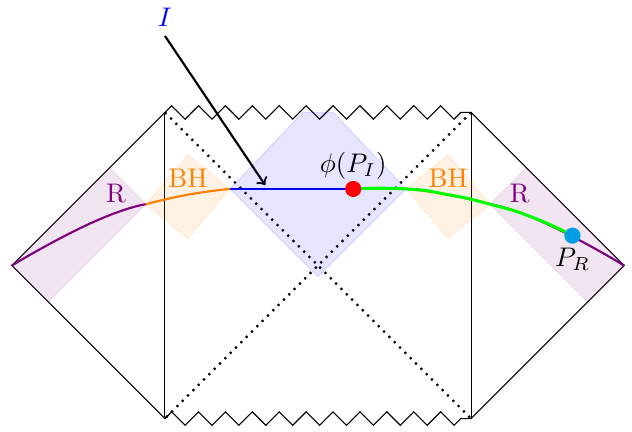
Figure 2 . The Penrose diagram of the AdS black hole attached to the non-gravitating heat bath with a small local operation φ ( P I ) ( P I ∈ I , red dot) in the island region I . The entanglement wedge of the black hole BH (orange shaded region) includes the asymptotic AdS boundary. The gravitational Wilson line W ( P I , P R ) (green line) connecting two points P I and P R ( P R ∈ R , cyan dot) intersects the entanglement wedge of the black hole (orange shaded